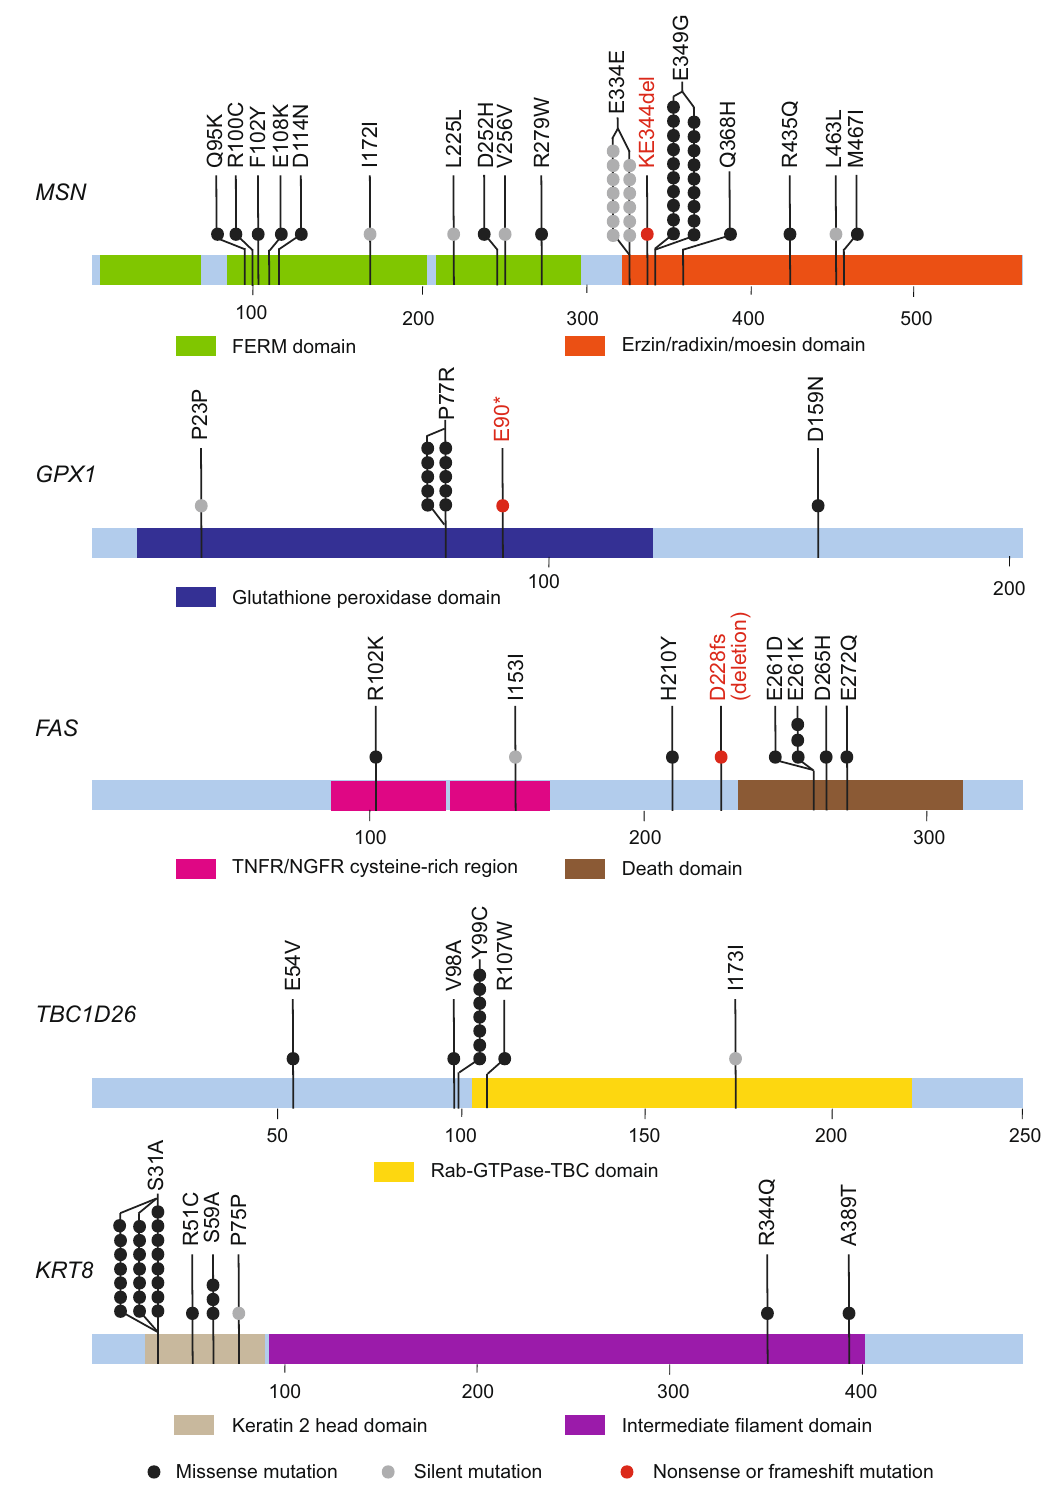
Fig. 1 Somatic mutations in previously unreported signi fi cantly mutated genes (SMGs) among 430 exome-sequenced cervical carcinomas. Protein-coding portions of each SMG are displayed, and numbers refer to amino acid residues. Each highlighted section represents UniProt/Pfam functional domains. Circles represent a single mutation with black, gray, and red circles representing missense, silent, and nonsense or frameshift mutations, (Supplementary Table 11), whilst in the non-SCC group, ampli fi ed ampli fi cation peaks (Supplementary Table 10b). Within the SCCs, and mutated oncogenes were associated with proliferation, ampli fi ed and mutated oncogenes were associated with apopto- cytokine signaling, and positive regulation of cell death (Supple- tic-, proliferative-, ERBB2-, and PI3K/AKT/mTOR signaling, regula- mentary Table 12). tion of cell death, and TNF signaling via NF- Κβ signaling